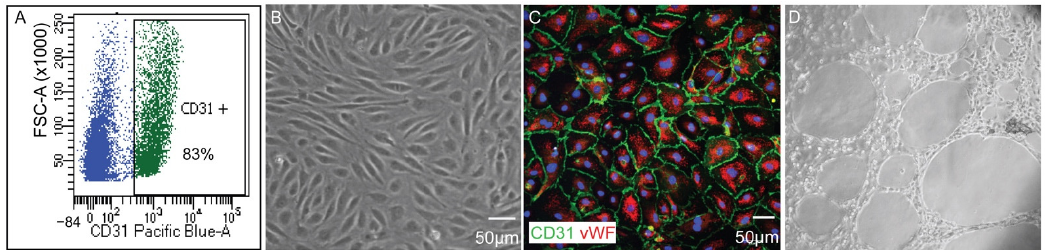
Figure 1. Characterization of human primary choroidal endothelial cells (1 ◦ CEC). ( A ) 1 ◦ CEC stain 83% positive for CD31 as demonstrated by flow cell cytometry analysis. ( B ) 1 ◦ CEC grown to confluence maintain a “cobblestone-like” appearance as observed with light microscopy. ( C ) 1 ◦ CEC stain positive for pan-endothelial surface marker CD31 (green) and Von Willebrand Factor (vWF, red). ( D ) Tube formation assay of 1 ◦ CECs. FSC-A = forward scatter area; aquablue = live-dead stain for live cell gating. Magnification bar = 50 µ